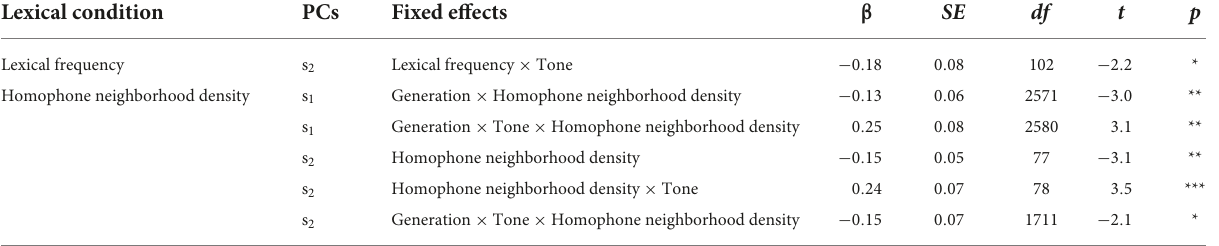
Homophone neighborhood density